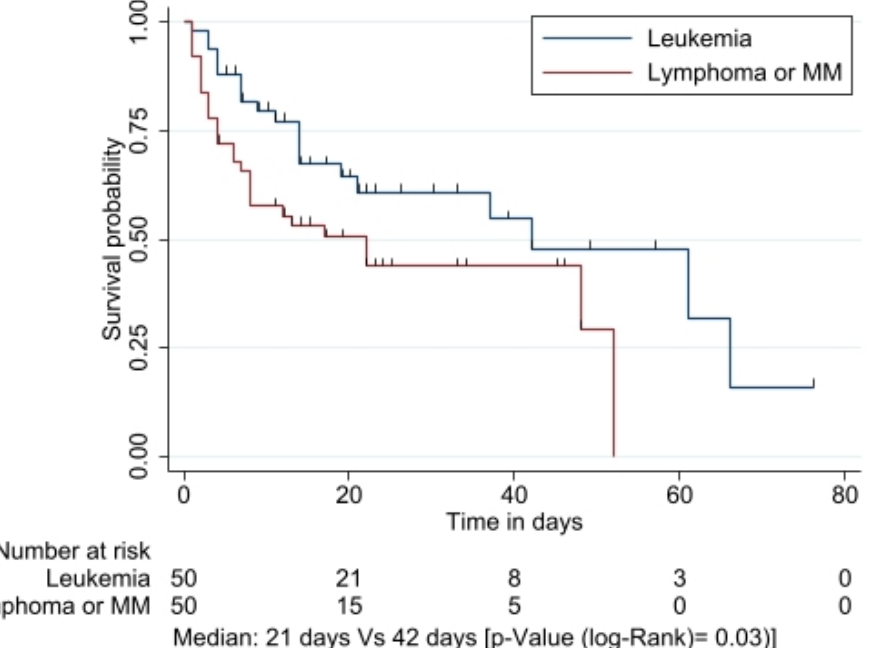
Figure 3. Kaplan–Meier overall survival curve by HM group.